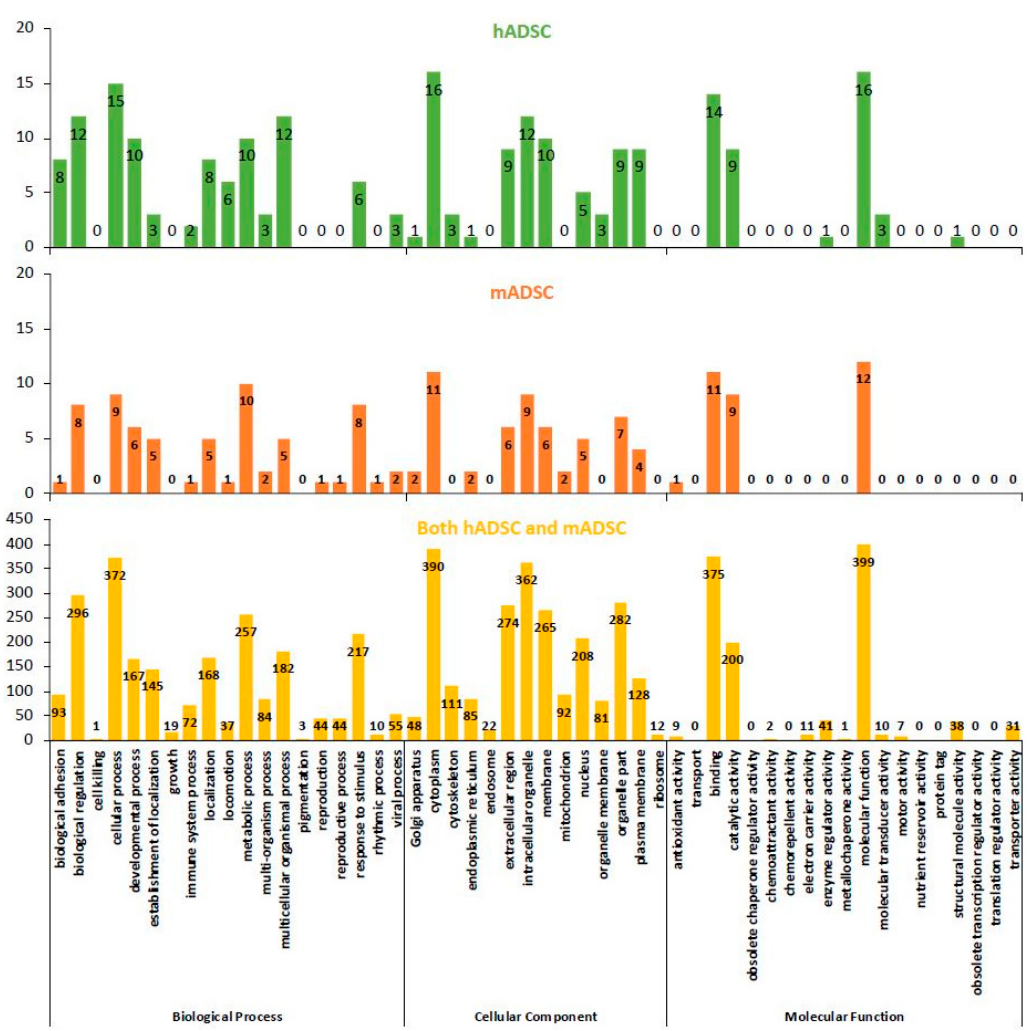
Figure 3. The biological processes, cellular components, and molecular functions of the hADSC, mADSC, and both hADSC and mADSC groups (determined by the Gene Ontology, GO, analysis). The principal component analysis (PCA) of proteome dynamics based on the protein information generated by high-resolution mass spectrometry. The abscissa indicates the biological function, cellular component, and molecular function of the protein. The ordinate indicates the number of proteins identified in the hADSC (top panel), mADSC (middle panel) and both hADSC and mADSC groups (bottom panel). The names of the proteins classified in Table 1 and Supplementary Table S1 are listed according to their detailed biological process (biological adhesion, locomotion, and rhythmic process), cellular component (plasma membrane), and molecular function (antioxidant activity and molecular transducer activity).